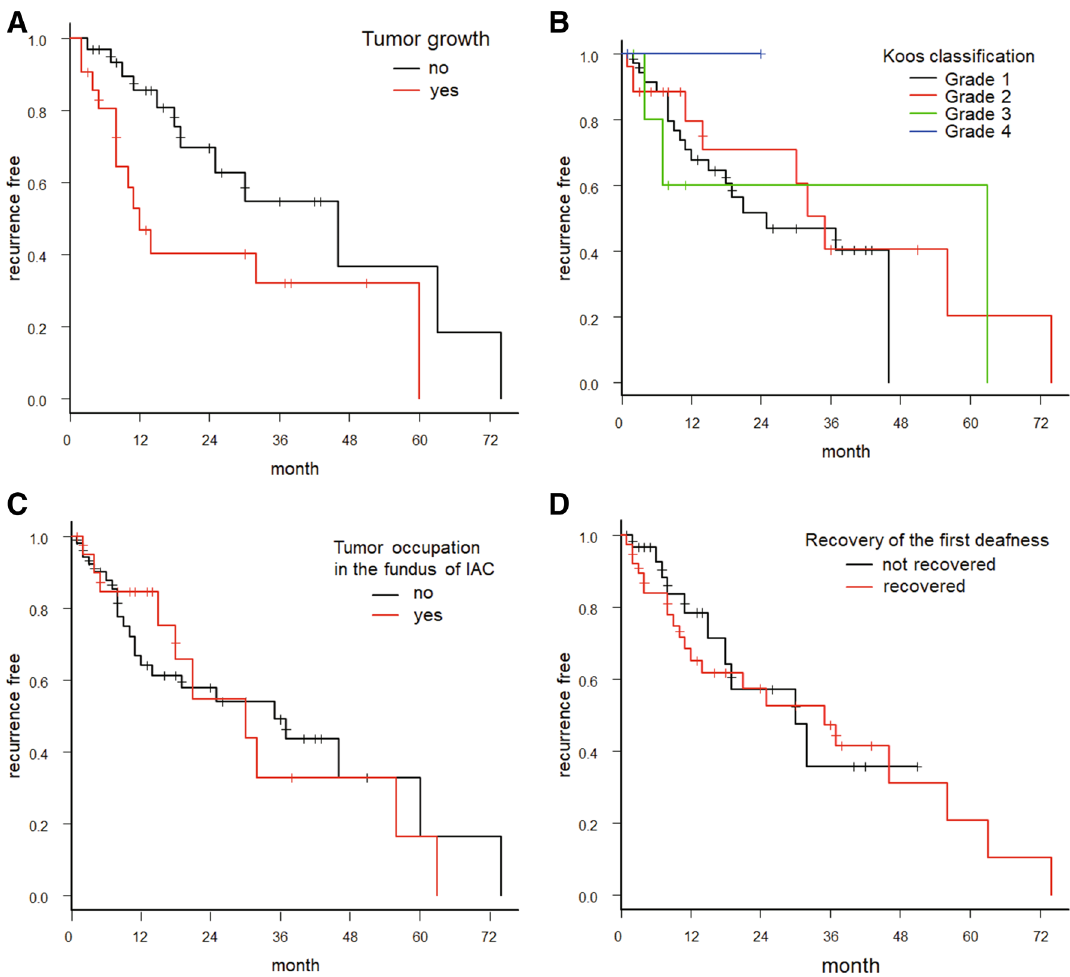
Figure 6. Kaplan–Meier curves for recurrence of sensorineural hearing loss and whether VS tumor showed growth (increase of 2 mm or more in the tumor’s maximum diameter axis). Median months (95% confidence interval); NA: not available. ( A ) Kaplan–Meier curves for recurrence-free period plotted separately for tumor growth (yes, red) or not (no, black). Tumor growth (no), 46 months (19-NA); Tumor growth (yes), 12 months (8-NA); P = 0.030. ( B ) The Kaplan–Meier curves for recurrence-free period plotted separately by Koos size classification of tumor. Grade 1, 25 months (12-NA); Grade 2, 35 months (14-NA); Grade 3, 63 months (4-NA); Grade 4, NA; p = 0.82. ( C ) The Kaplan–Meier curves for recurrence-free period plotted separately for VS tumors in the fundus of internal auditory canal (IAC) or not. Occupying the fundus (no, black), 35 months (12–60); Occupation (yes, red), 30 months (15–56); P = 0.92. ( D ) Kaplan–Meier curves for recurrence-free period plotted separately for recovered from first sudden sensorineural hearing loss episodes, or not. Not recovered, 30 months (12-NA); Recovered, 35 months (11–56); P = 0.73. We used EZR ver.1.40 15 to create these Kaplan–Meier